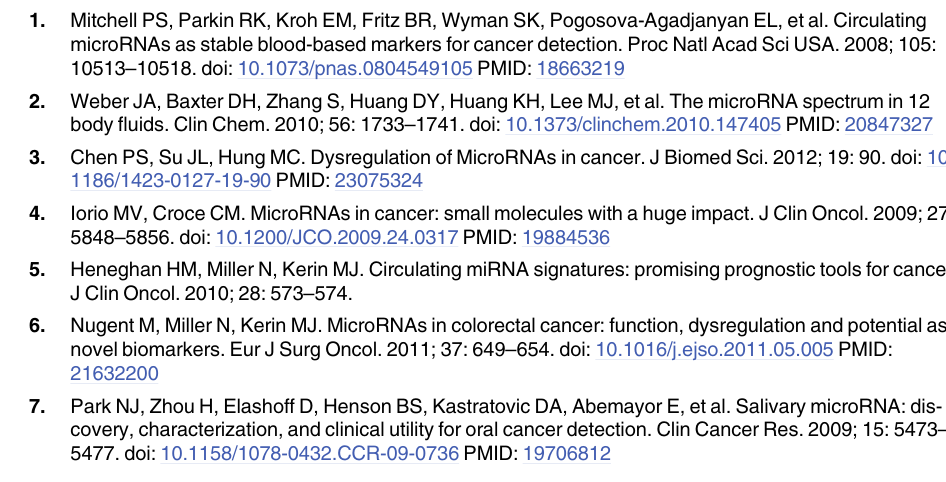
S1 Table. Average Ct and average Δ Ct values from the discovery phase. In the discovery phase, the expression of miRNAs in whole saliva from patients with a parotid gland neoplasm (n = 20) were compared to the expression of miRNAs in whole saliva from controls (n = 10). S2 Table. Average Ct and average Δ Ct values from the validation phase. Data of the valida- tion of 8 miRNAs in an independent sample set consisting of 46 whole saliva samples from patients with a parotid gland neoplasm and 14 whole saliva samples from